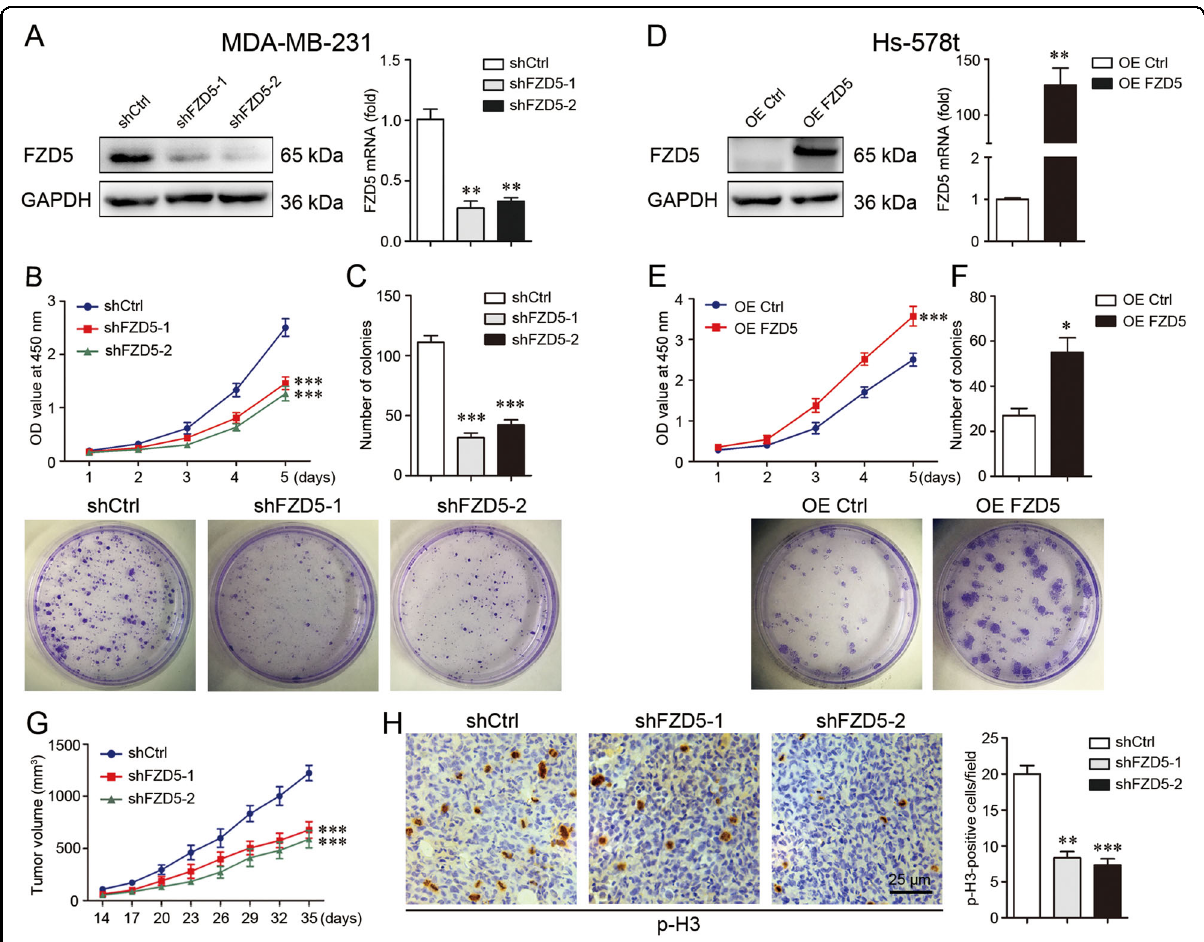
Fig. 2 FZD5 induces cell growth in vitro and in vivo. A FZD5 expression in MDA-MB-231 cells stably transfected with shCtrl or shFZD5-1/2 was detected by Western blot and real-time PCR. B Viability of MDA-MB-231 cells was analyzed by CCK8. C Growth of MDA-MB-231 cells was determined by Colony formation, mean ± SD, n = 3. ** P < 0.01, *** P < 0.001, vs. shCtrl. D FZD5 expression in Hs-578t cells stably transfected with OE Ctrl or OE FZD5 was detected by Western blot and real-time PCR. E Viability of Hs-578t cells was analyzed by CCK8. F Growth of Hs-578t cells was determined by colony formation, mean ± SD, n = 3. * P < 0.05, ** P < 0.01, *** P < 0.001, vs. OE Ctrl. G Growth curves of xenograft tumors from MDA-MB-231 cells were shown. H Phosphorylated histone 3 (p-H3) expression in xenograft tumors was detected by immunohistochemistry. Scalebar: 25 μ m, mean ± SD, n = 5. ** P < 0.01, *** P < 0.001, vs.